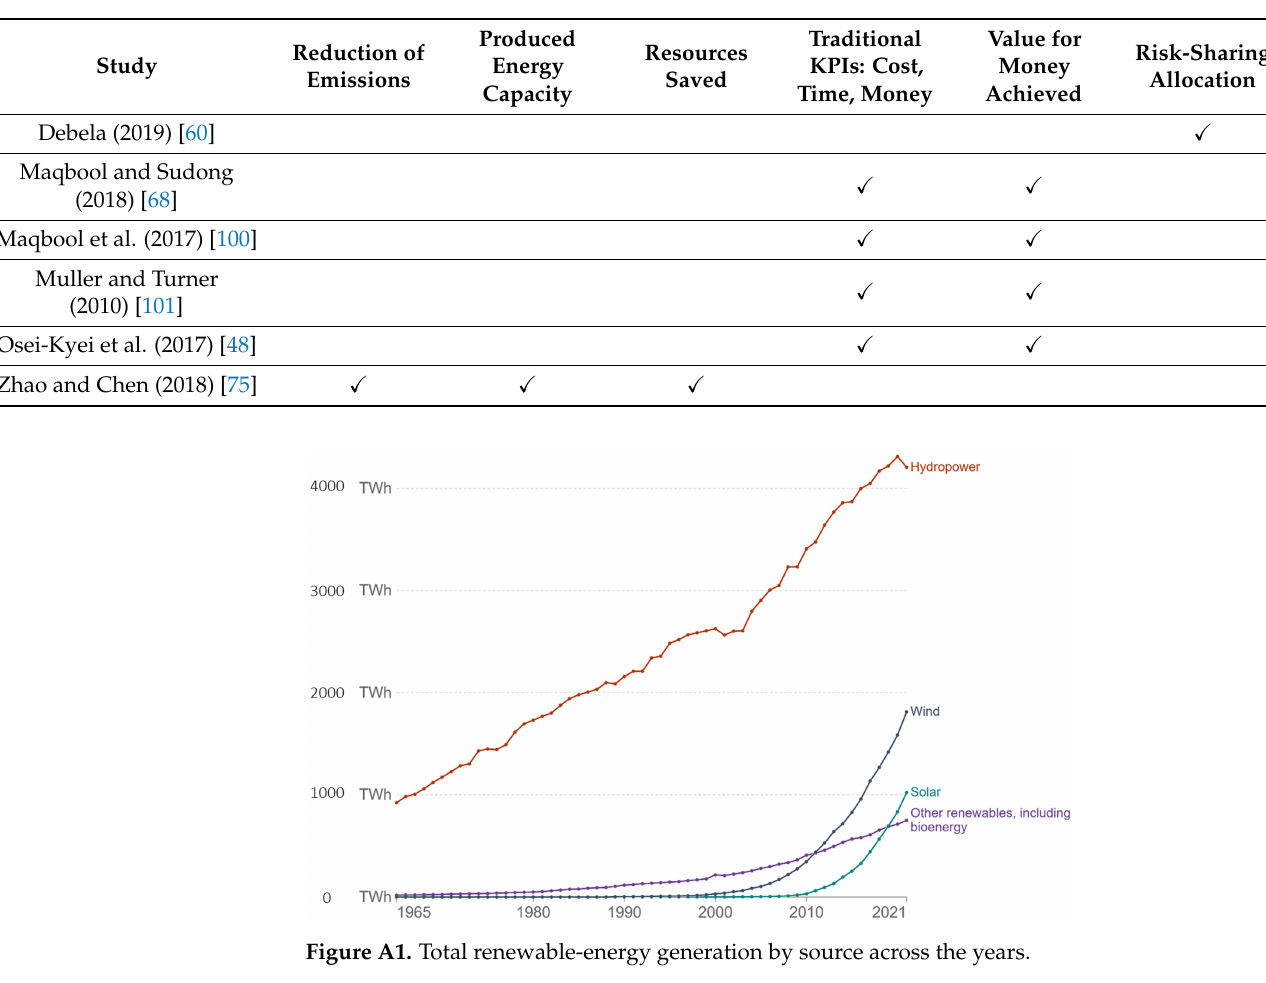
Table A4. Key performance indicators investigated in the different studies in the literature.